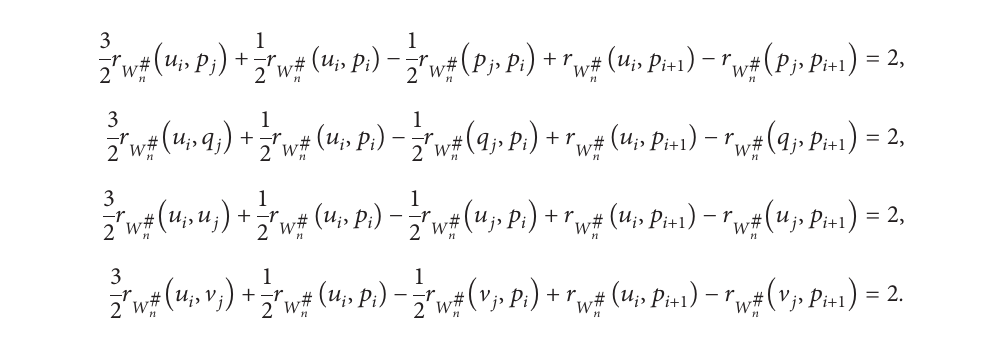
Figure 8: The network W #